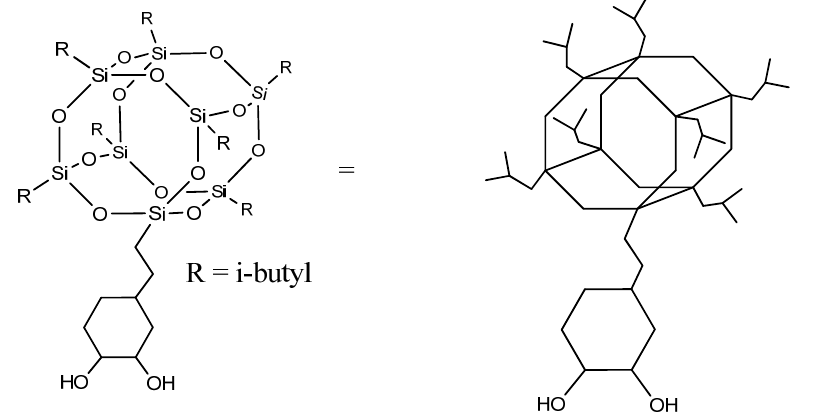
Figure 1. Cyclohexanediol isobutyl POSS (POSS-OH).